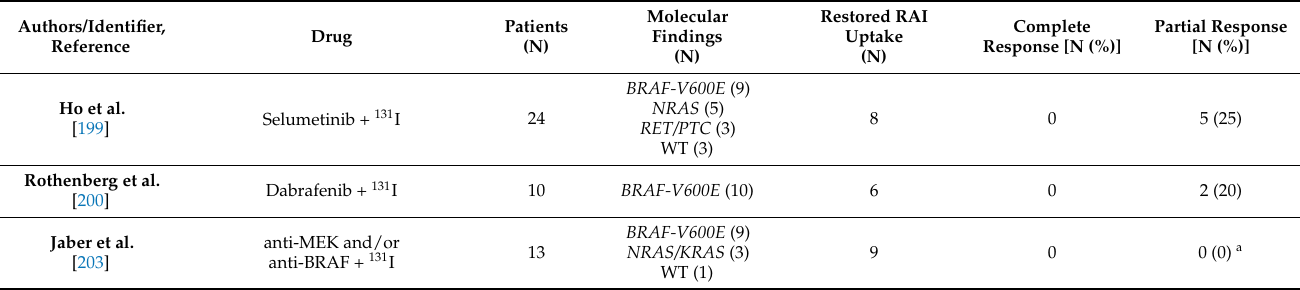
Table 6. Overview of published or ongoing studies on redifferentiation with anti-MEK or anti- BRAF